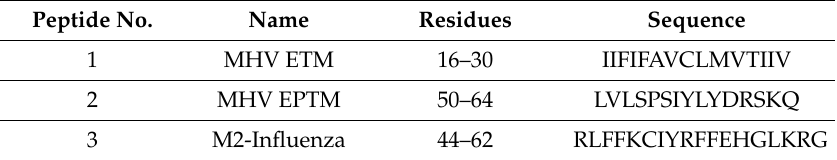
Table 1. Peptides used for in vitro GUV deformation analysis. Peptide